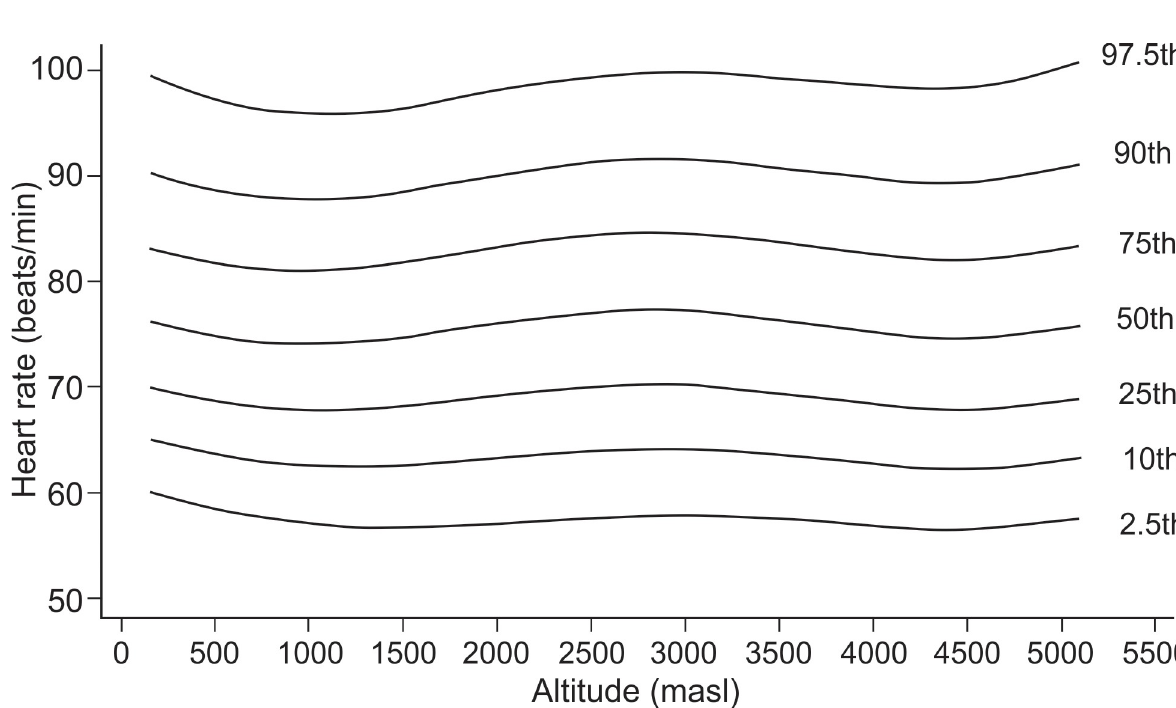
Fig 4. Heart rate at rest according to altitude of residence in Peruvian adults of 51–80 years of age.